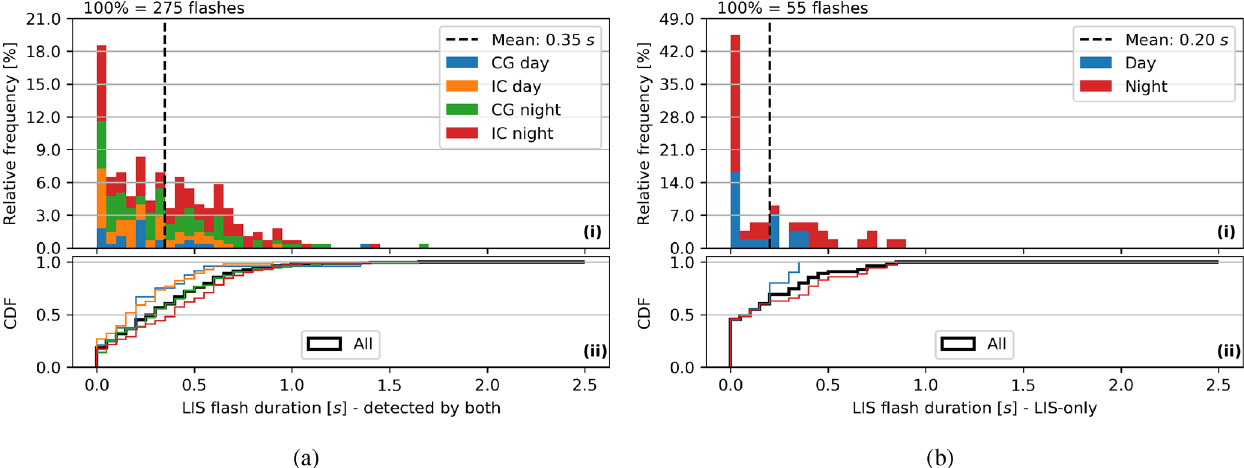
Figure 9. Flash duration of ISS-LIS flashes with a coincident Meteorage flash (a) and unmatched ISS-LIS flashes (b) . Daytime, nighttime and flash type, IC and CG, are indicated by the colors. The histogram (i) and corresponding CDF (ii) use the same colors. The CDF additionally shows a black curve for all data. The histogram bin width is constant at 0.05s. Note: the CG–IC attribute for an ISS-LIS flash needs the matched Meteorage flash and does not exist for ISS-LIS-only flashes. The mean value is plotted as a dashed line. The total number of flashes is indicated above the